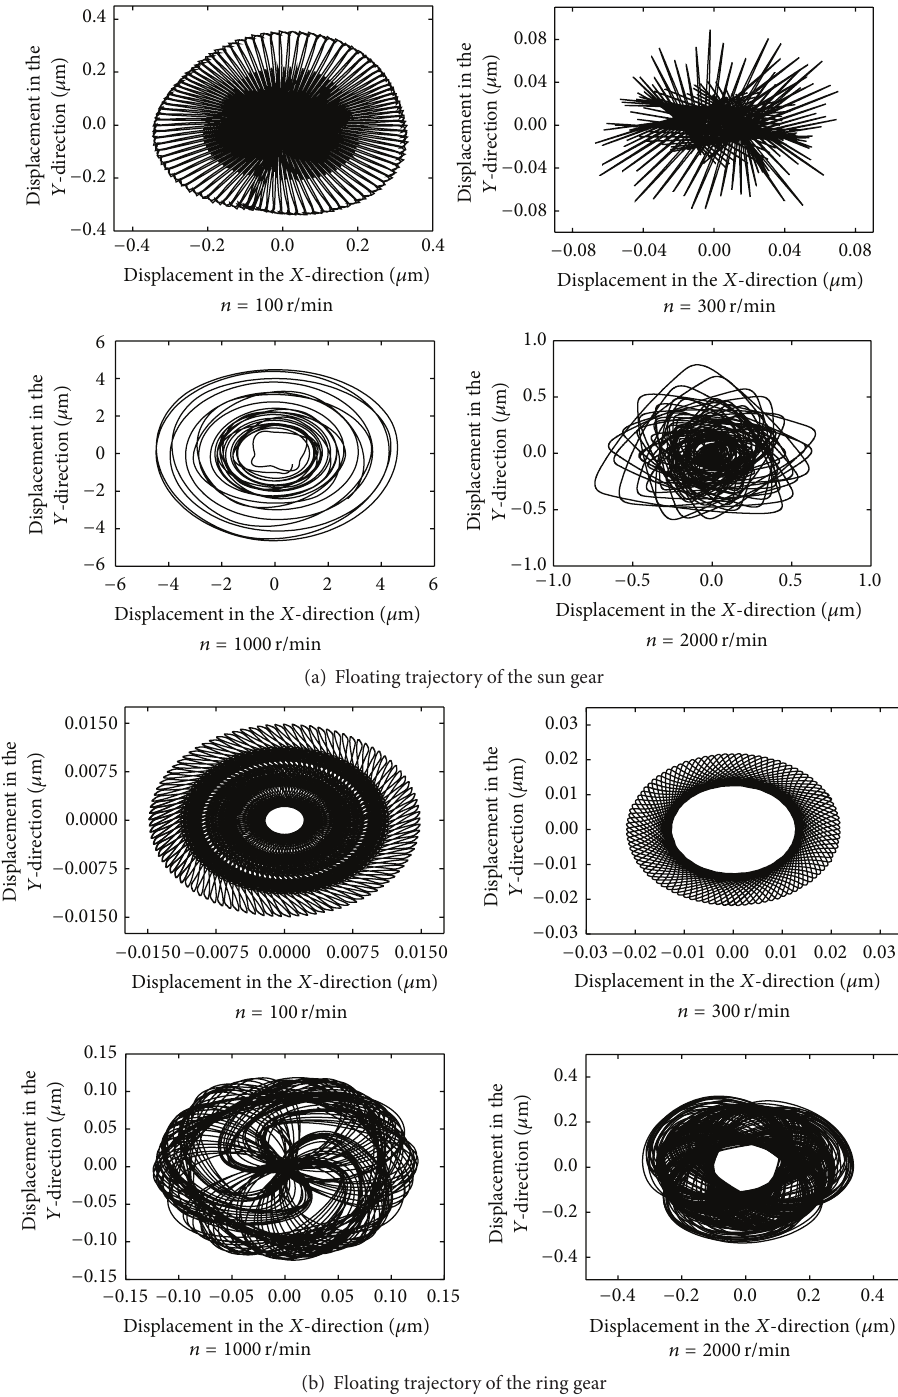
Figure 12: Floating trajectory of center gear at various